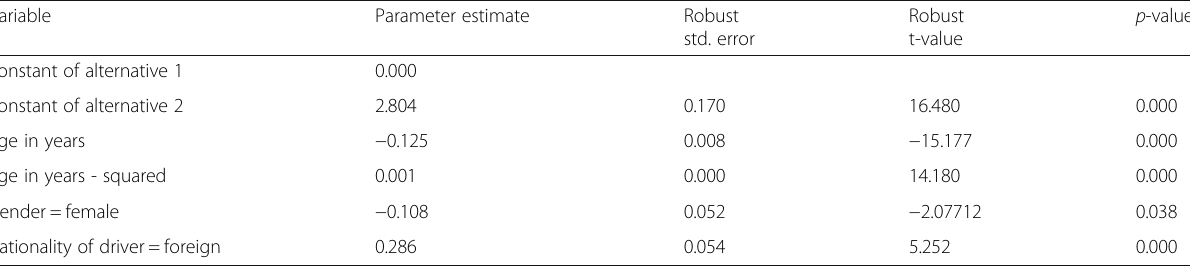
Table 4 Binomial logit model of “ not responsible drivers ” (alternative 1 = reference) and “ mainly responsible drivers ” (alternative 2); sample = car drivers with specified responsibility involved in a motorway crash; predictors = personal and vehicle characteristics